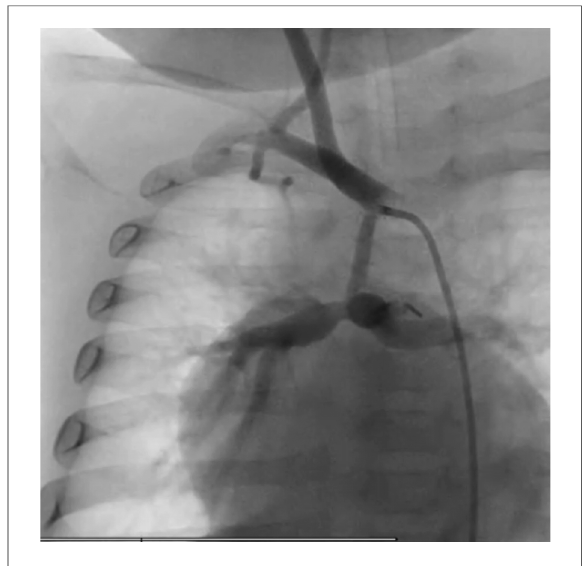
FIGURE 1 Angiography evidence of the restrictive fl ow pattern and the reduction size of the MRBT shunt (PECA exGraft).